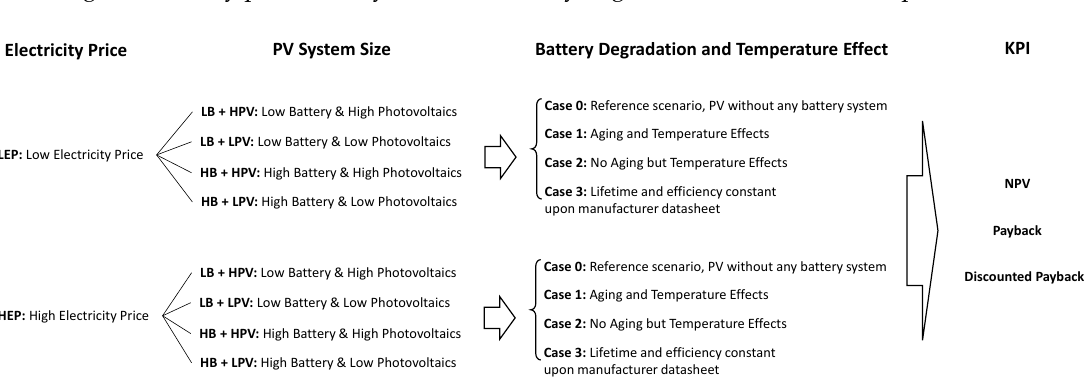
Figure 5. Combination of the scenarios that have been analysed.